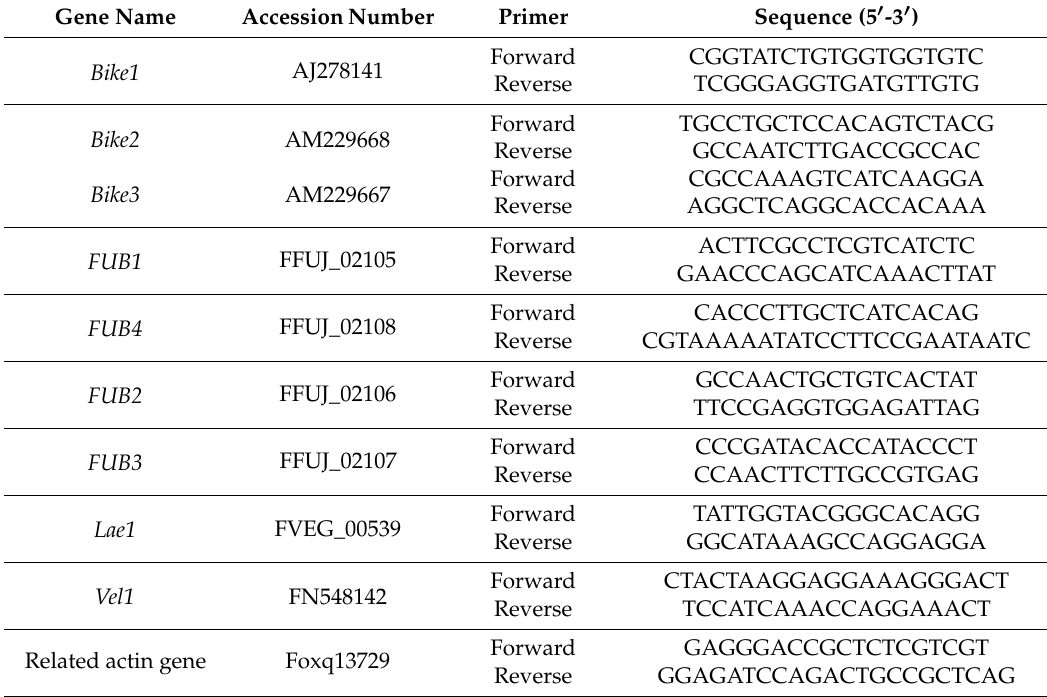
Table 3. qRT-PCR primers applied in this